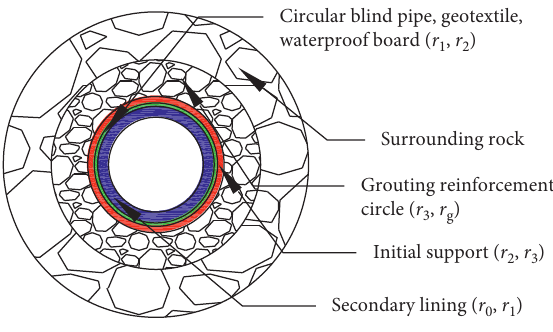
Figure 1: Calculation model.